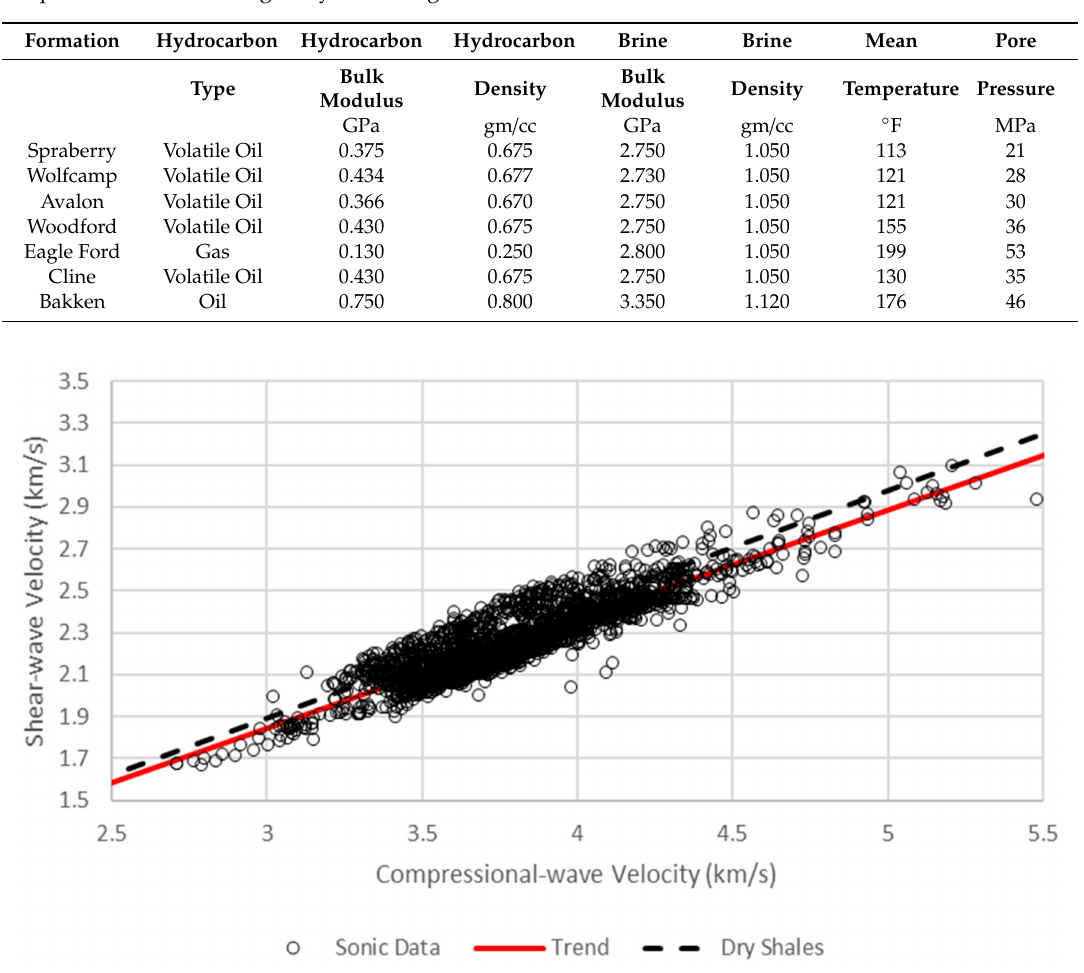
Table 2. Average fluid properties for the shale reservoirs studied here. Moduli are based on the Batzle and Wang [31] equations ((8) to (10)) for gas and ((20) to (24)) for oil and adjusted for composition and in situ pressure and temperature. By volatile oil we mean gas / oil ratios above 1000 standard cubic feet per barrel and an API gravity of 40 ◦ or greater.